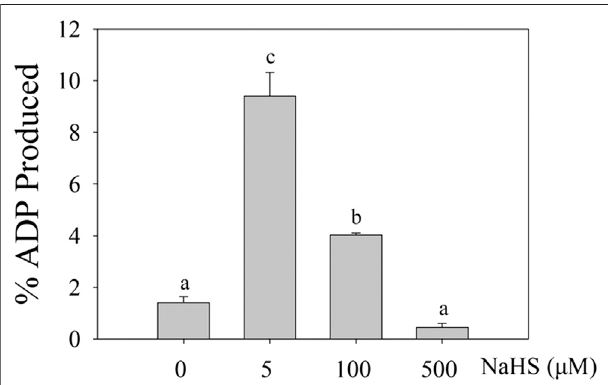
FIGURE3| TheeffectofH 2 SontheactivityofMPK4.The0.2 μ gpuri fi ed MPK4was fi rstactivatedby0.05 μ gpuri fi edMEK2EE,thentreatedwith0 μ M, 5 μ M, 100 μ M and 500 μ M NaHS in 4 ° C for 30 min. Activated MPK4 was incubated with MBP (1:10 enzyme substrate ration), and the activity of MPK4wascalculatedbytheconversionofATPtoADPusingADP-GloKinase Assay (Promega). Data are Mean ± SE and three independent experiments were repeated, different letters indicated signi fi cant differences among treatments (one way ANOVA p < 0.05).